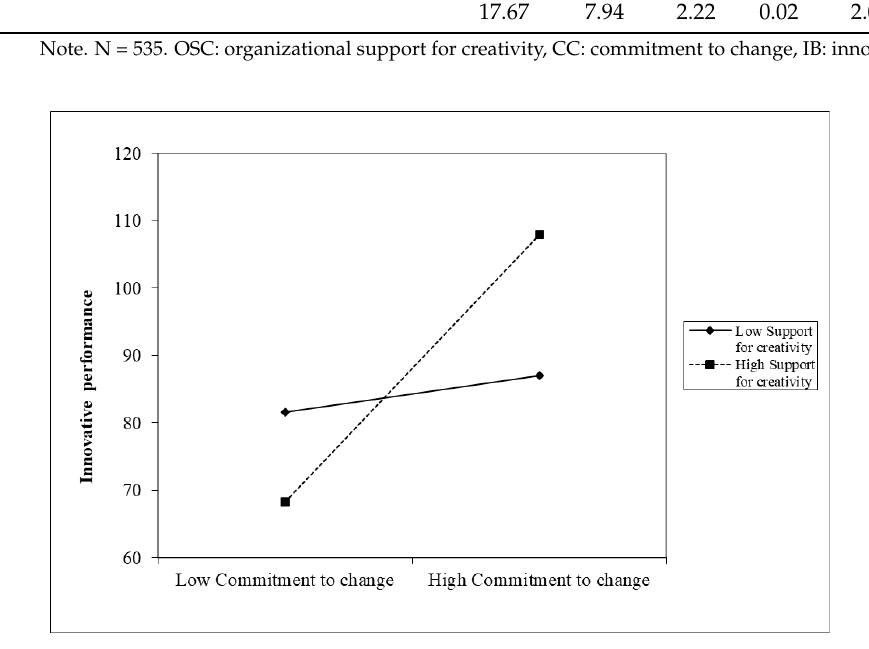
Figure 3. Interaction effects of support for creativity on innovative behavior